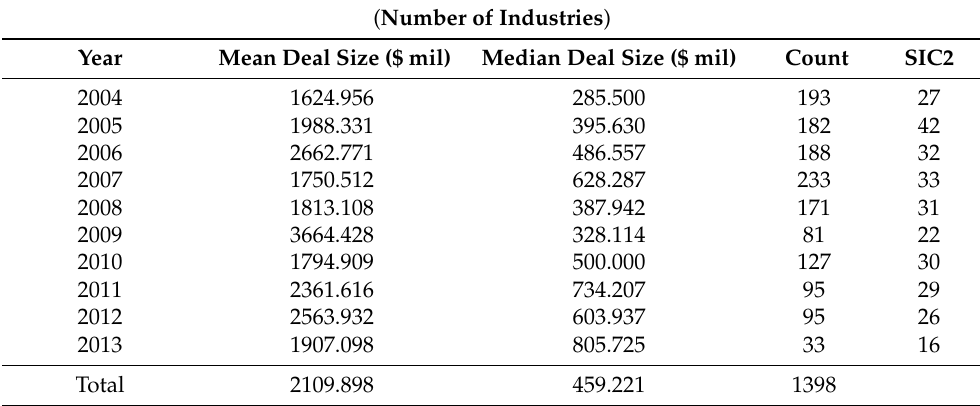
Table 1. M&A Sample